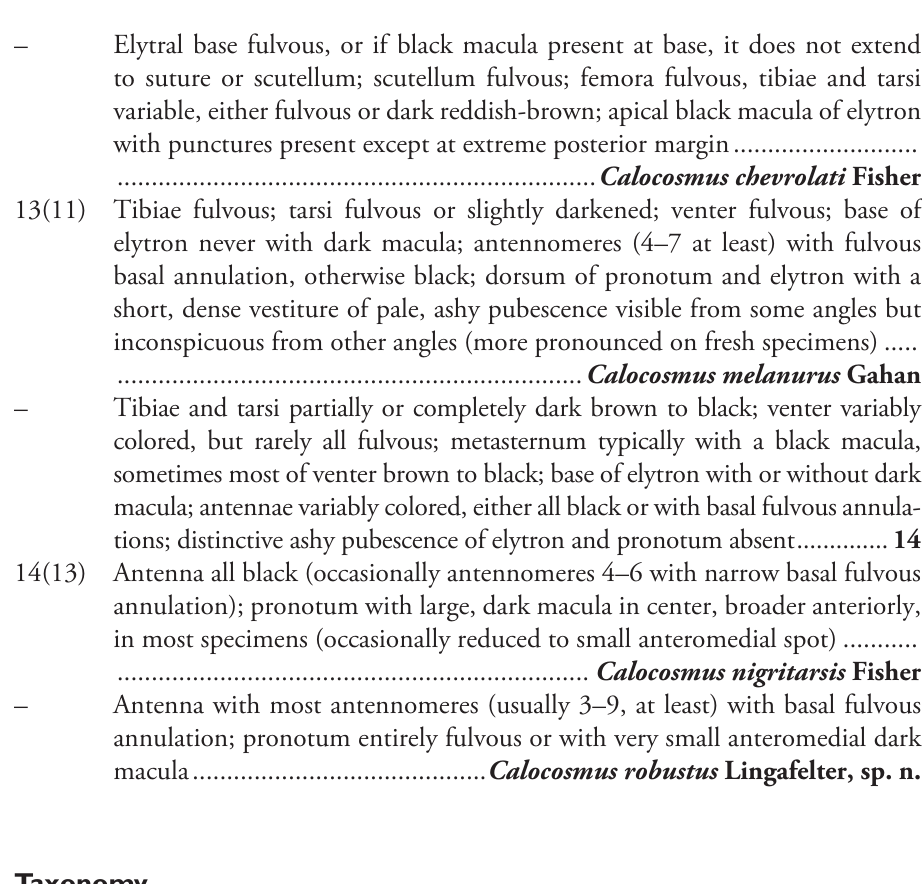
Diagnosis. This species is unlike any other species in the Caribbean Islands. It is very similar to A. nigrocinctus Gahan, from Brazil, in the overall form, proportions, and antennal and elytral pubescence. It is distinguished from all other Hispaniolan hemi- lophines by the very long third antennomere, which, along with the basal half of the fourth is yellow, the densely pubescent pronotum without evident punctures, and the unique pattern of alternating white and black transverse fasciae on the elytra. with dense vestiture of appressed off-white setae, thickened at base, almost scale-like; most dense on frons, less dense around eyes, base of antennal tubercles and vertex. Punctures indistinct or hidden by pubescence. Frons not bulging, level to slightly con- vex between eyes with exception of small medial impression extending to vertex.